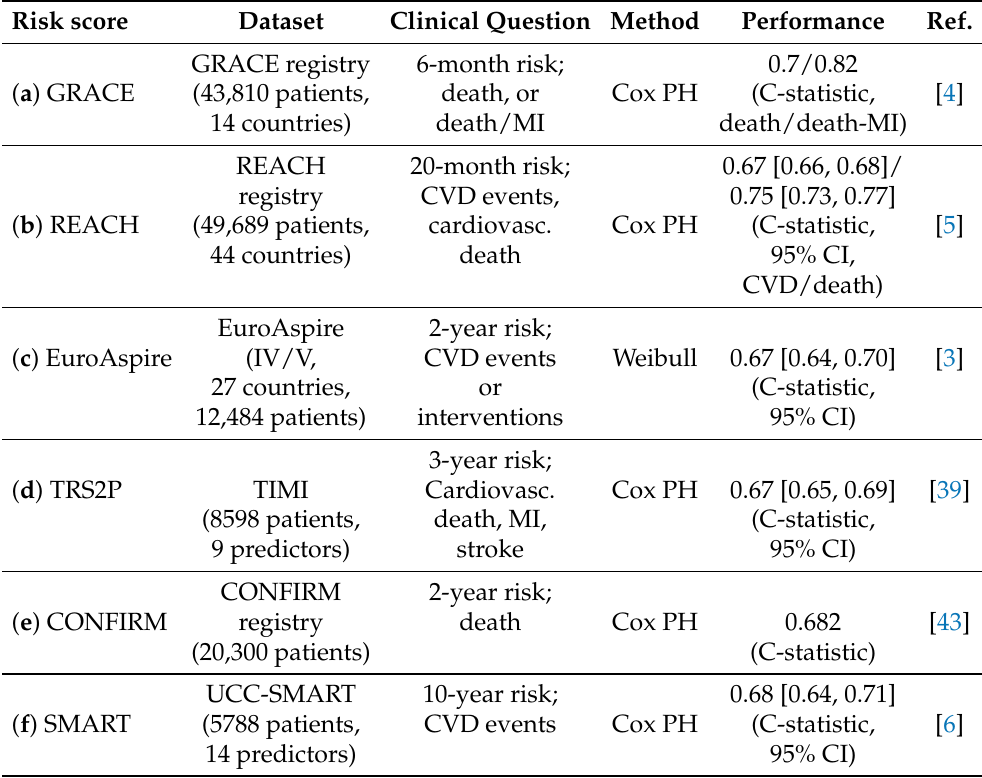
Table 4. Table of clinical risk scores for predicting recurrent events. CVD—cardiovascular disease;